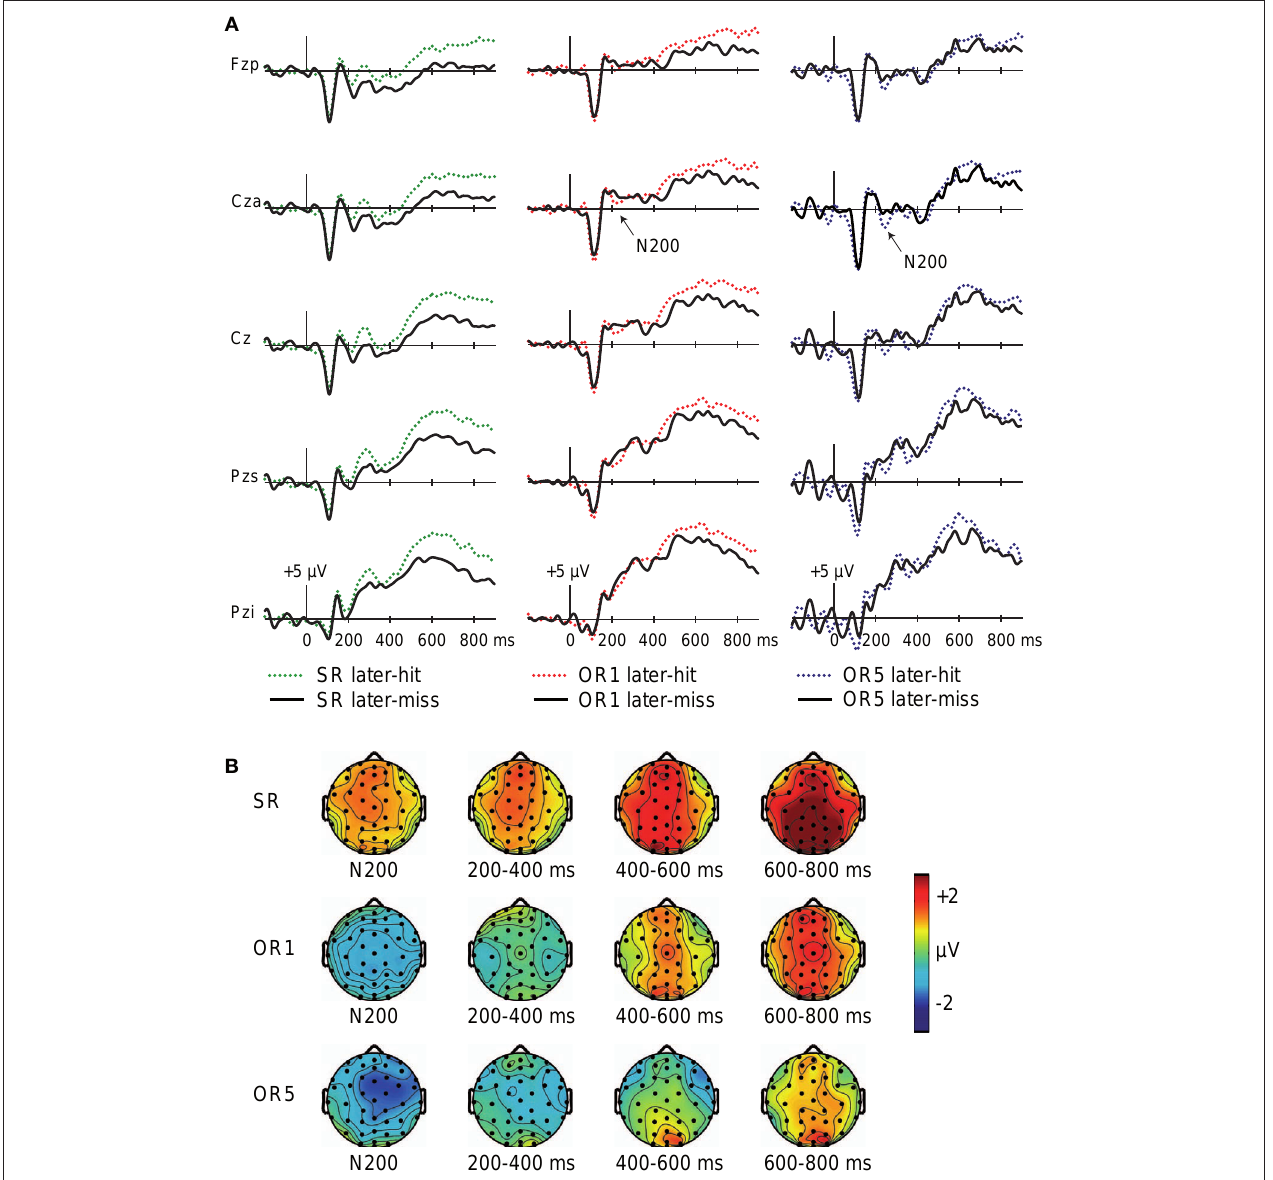
FiGuRE 3 | Subsequent-memory effects. (a) ERPs at encoding contrasted for subsequently remembered and subsequently forgotten faces for SR faces (left), OR1 faces (center), and OR5 faces (right, based on a subset of nine participants). Waveforms shown for five midline electrode locations (Fzp, Cza, Cz, Pzs, and Pzi). (B) Topography of corresponding subsequent-memory